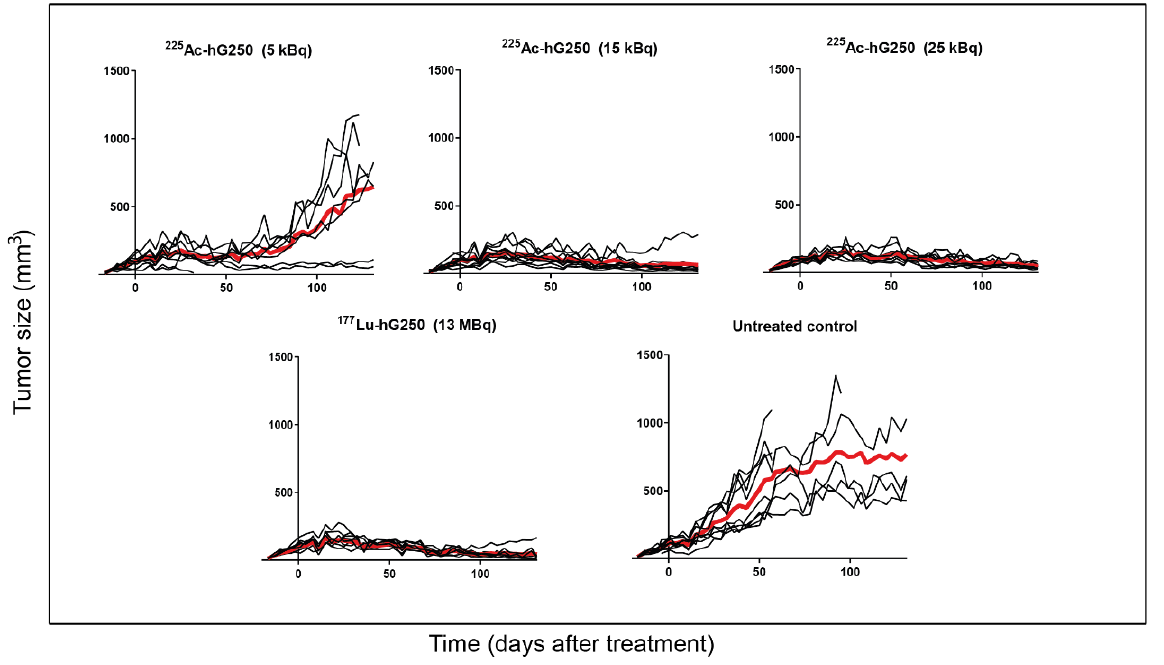
Figure 3. The tumor size over time in SK-RC-52 tumor-bearing mice, either untreated or treated with various activities of 225 Ac-hG250 or 177 Lu-hG250 (30 µg). The red line indicates the mean. Immunohistochemical analysis of tumor sections indicated a dose-dependent radiation effect after radionuclide-hG250 treatment at 150 days post-inoculation. The H&E-staining tumor specimens of mice treated with 15, 25 kBq 225 Ac-hG250 or 13 MBq 177 Lu-hG250 displayed late radiation effects, exhibited by enlarged nuclei, multinucleation, and intercellular fibrosis (Figure 4). This effect was not prominent in mice that received 5 kBq 225 Ac-hG250. Additionally, we observed that membrane expression of CAIX remained present across all treatment groups.